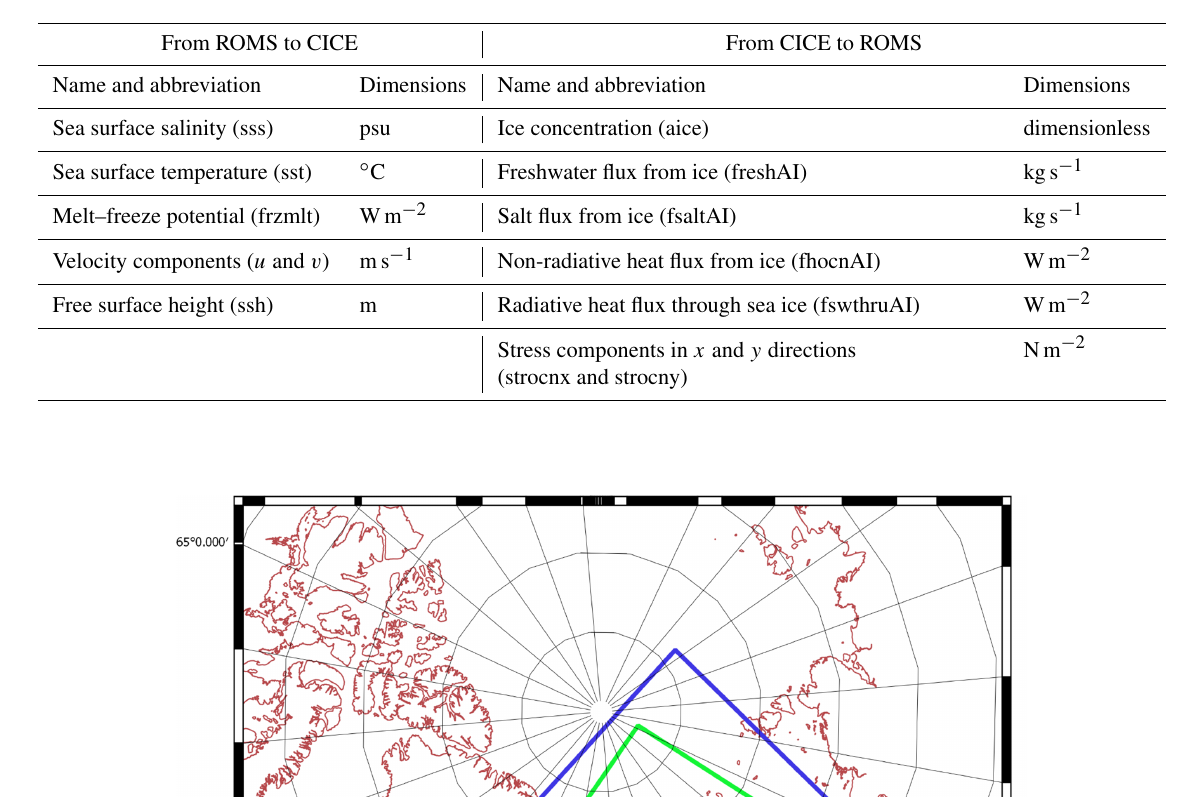
Table 1. Data exchange between ROMS and CICE through MCT (see text).